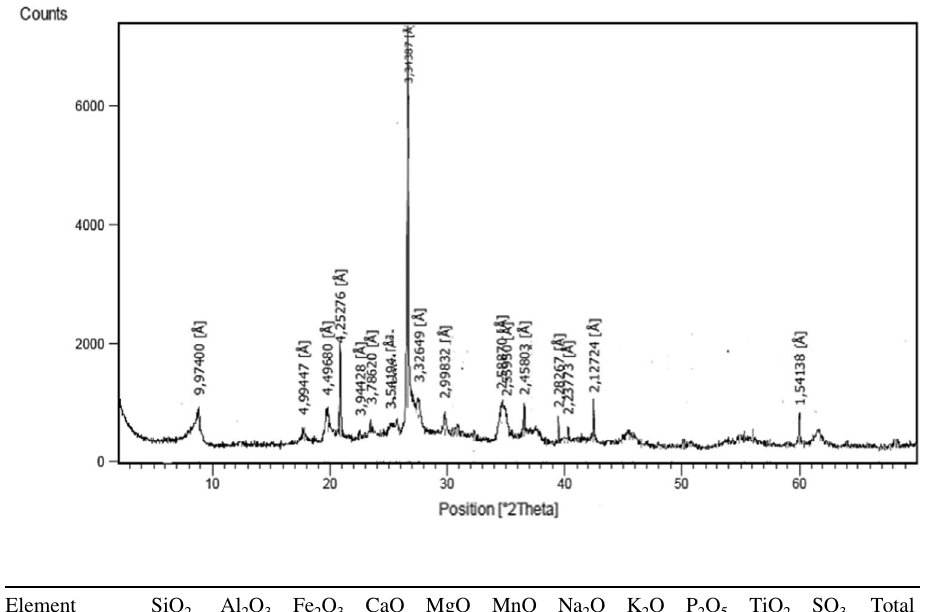
Fig. 3 XRD pattern of Kenadsa’s natural green clay (Bechar-Algeria)